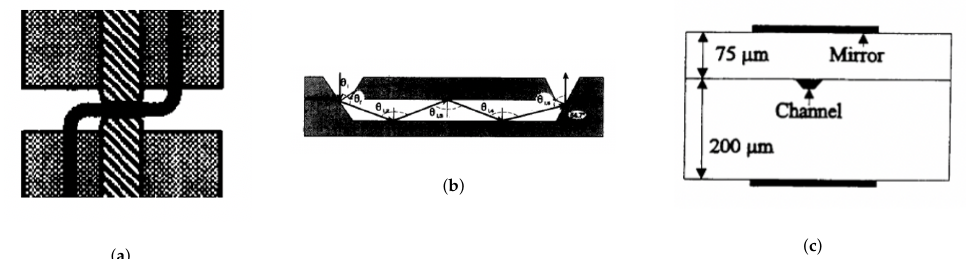
Figure 17. Initial approaches to overcome path length of on-chip absorbance detection ( a ) Z-shaped flow cells. Reprinted from [114]. Copyright © Elsevier 1991. ( b ) Silica multi-reflection cell. Reprinted from [117], copyright © Elsevier 1992. ( c ) Multi-reflection cell in glass with aluminium plating. Reprinted from [118], copyright © Electropheresis 2000.